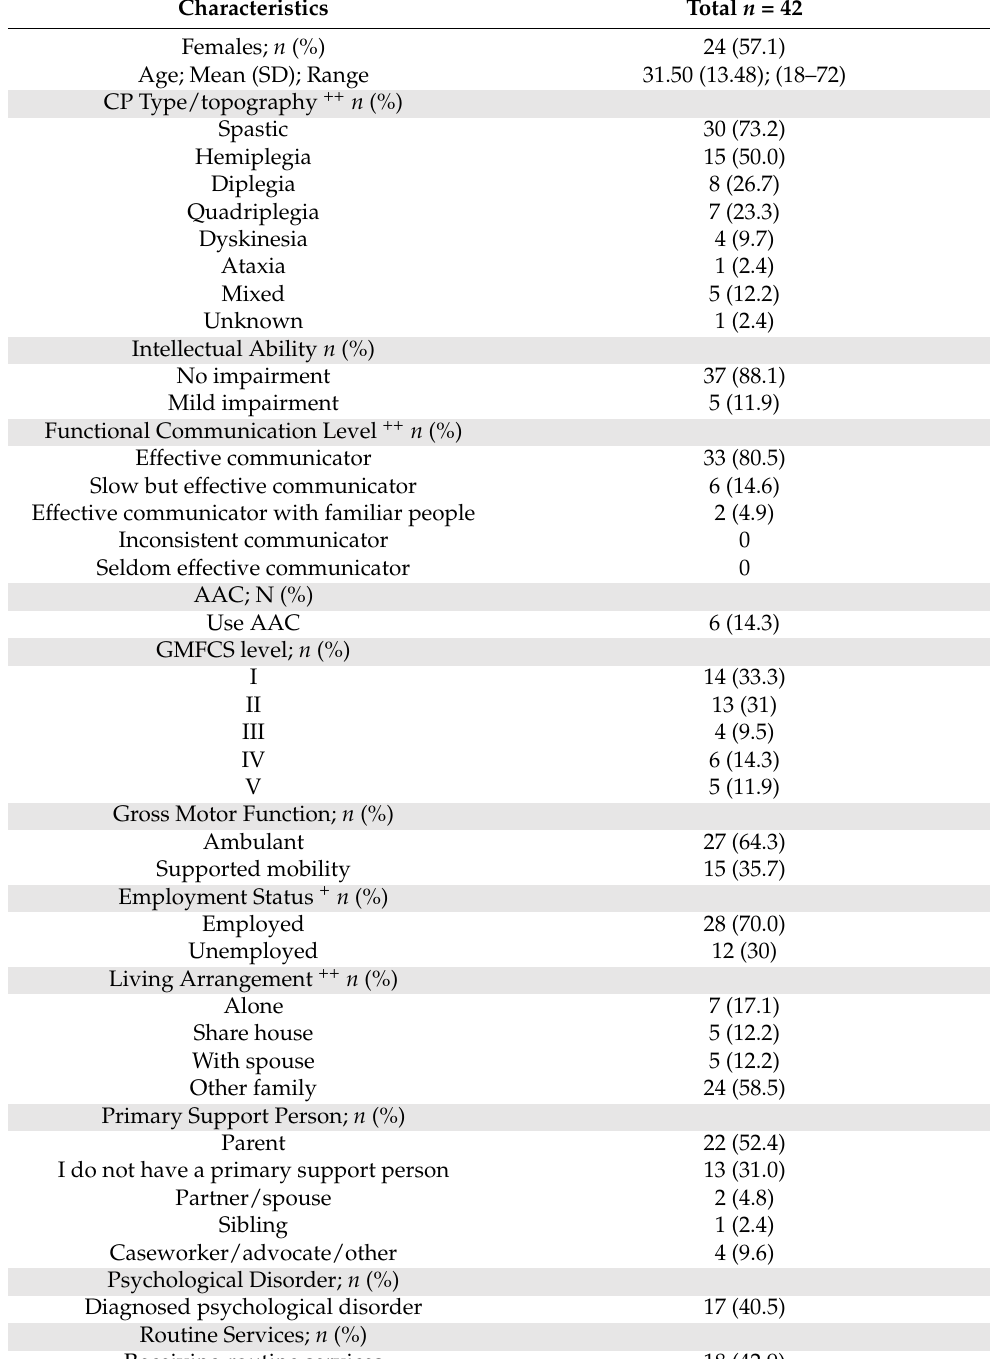
Table 1. Participant